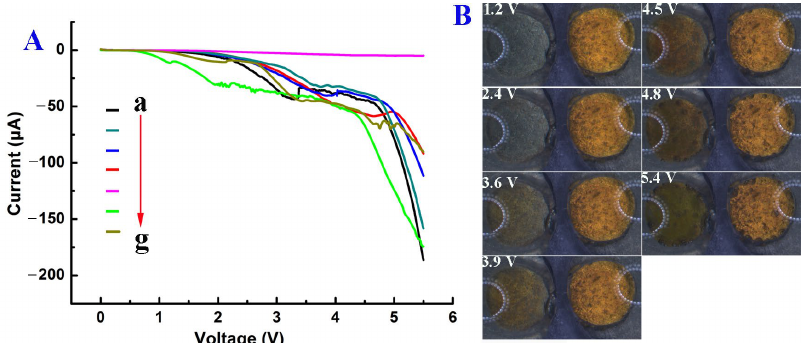
Figure 4. ( A ) LSV curves recorded during the second-step deposition of Au. The currents were obtained by filling the right reservoir with different solutions: 10 mM PBS (a), 5 mM PBS (b), 1 mM PBS (c), 0.5 mM PBS (d), water (e), 5 mM HAuCl 4 (f), and 5 mM HCl (g). The left reservoir was filled with 5 mM HAuCl 4 . ( B ) Optical images were recorded during the second deposition of Au under linear sweep voltage. Both reservoirs were filled with 5 mM HAuCl 4 . The applied voltage was changed from 0 to 5.5 V at a scan rate of 0.005 V/s.